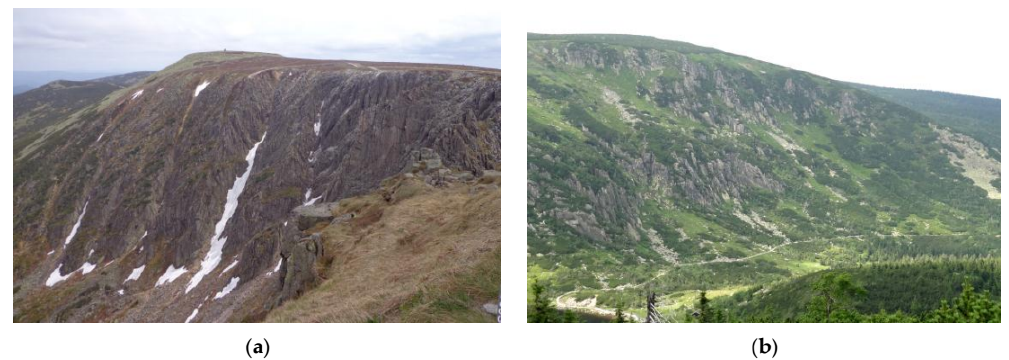
Figure 2. Mosaics of diverse vegetation communities in western ( a ) and eastern ( b ) Giant